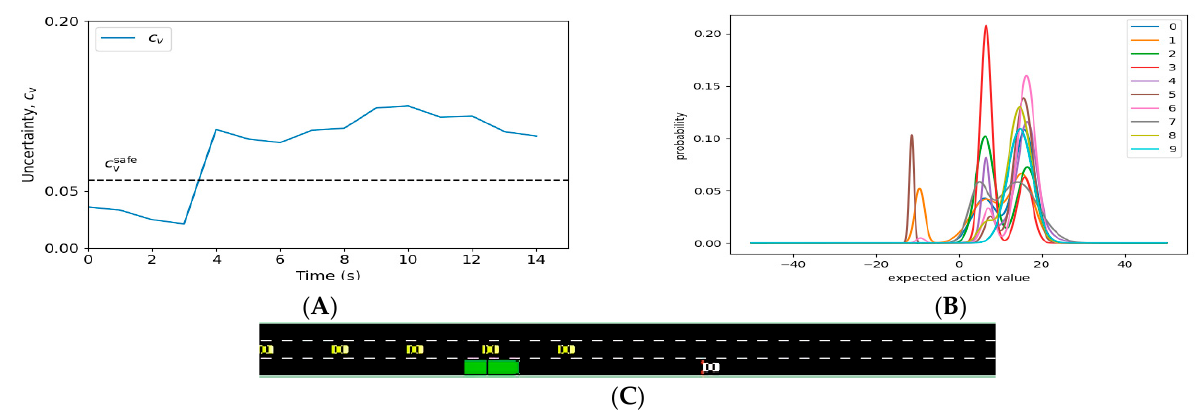
Figure 5. Uncertainty estimation result for stop scenario: ( A ) uncertainty result, ( B ) Gaussian mixture at maximum uncertainty at 4 s, and ( C ) Traffic condition display at 4 s.